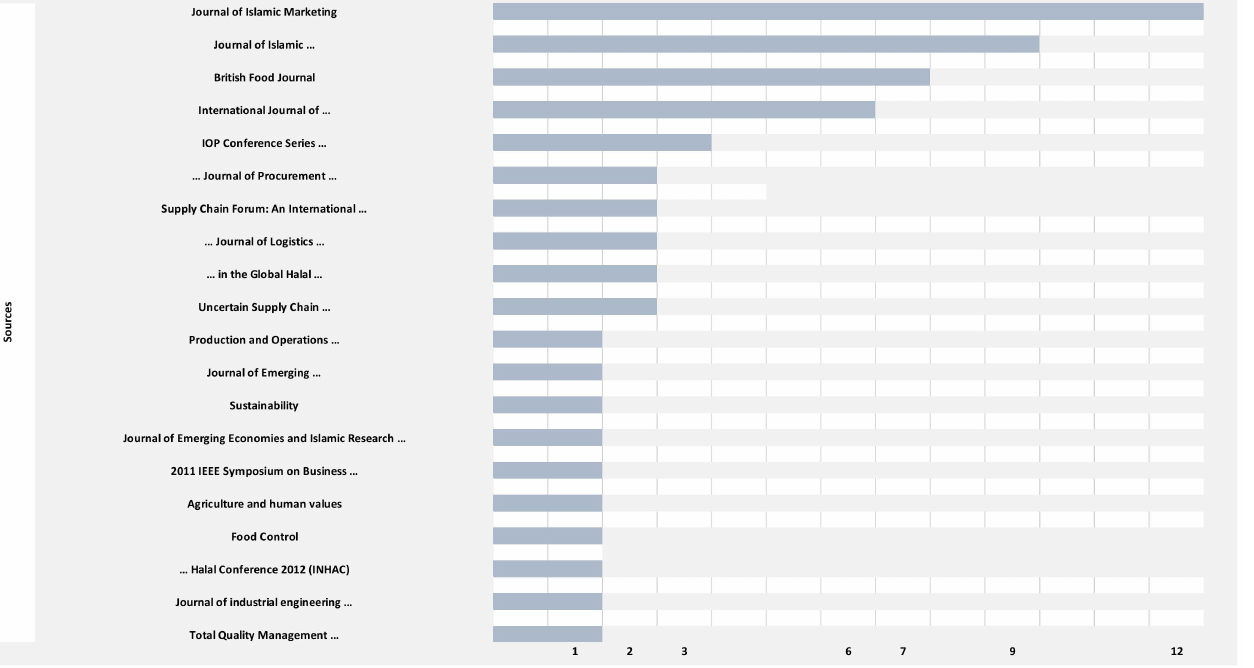
Figure 5. Relevant source